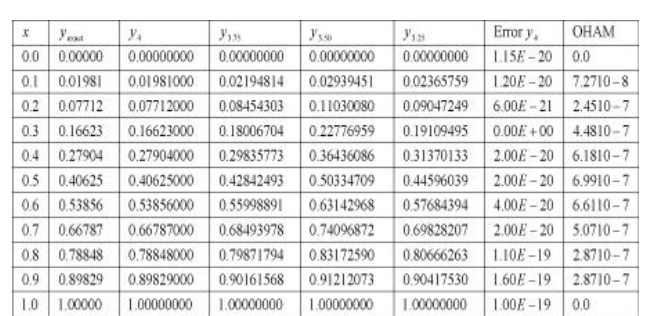
Table 1: Numerical results of Problem 1